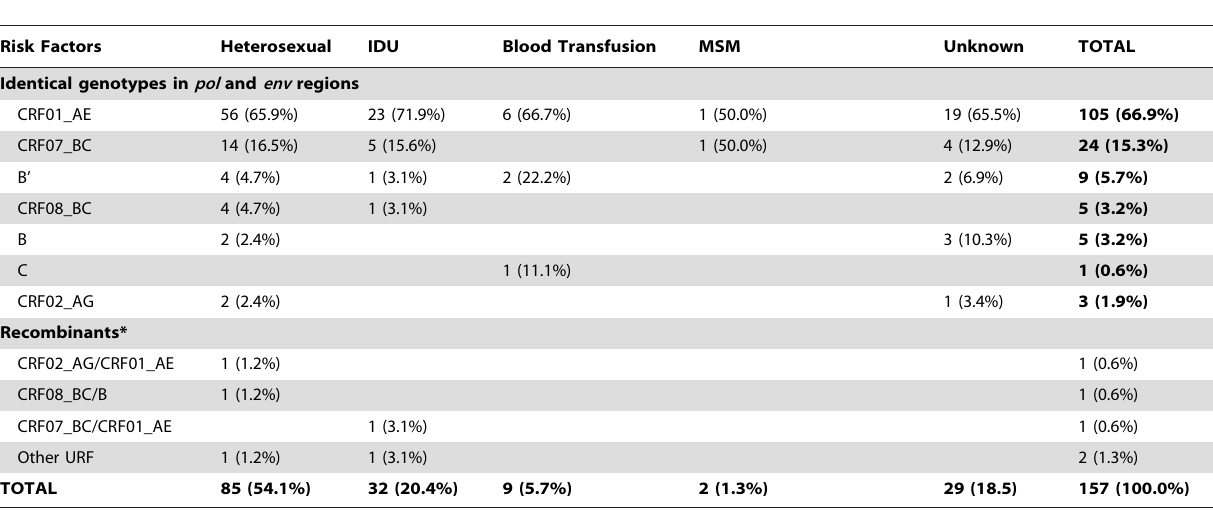
Table 1. HIV-1 genotypes in infected individuals in Guangdong, China (cases/percentage).